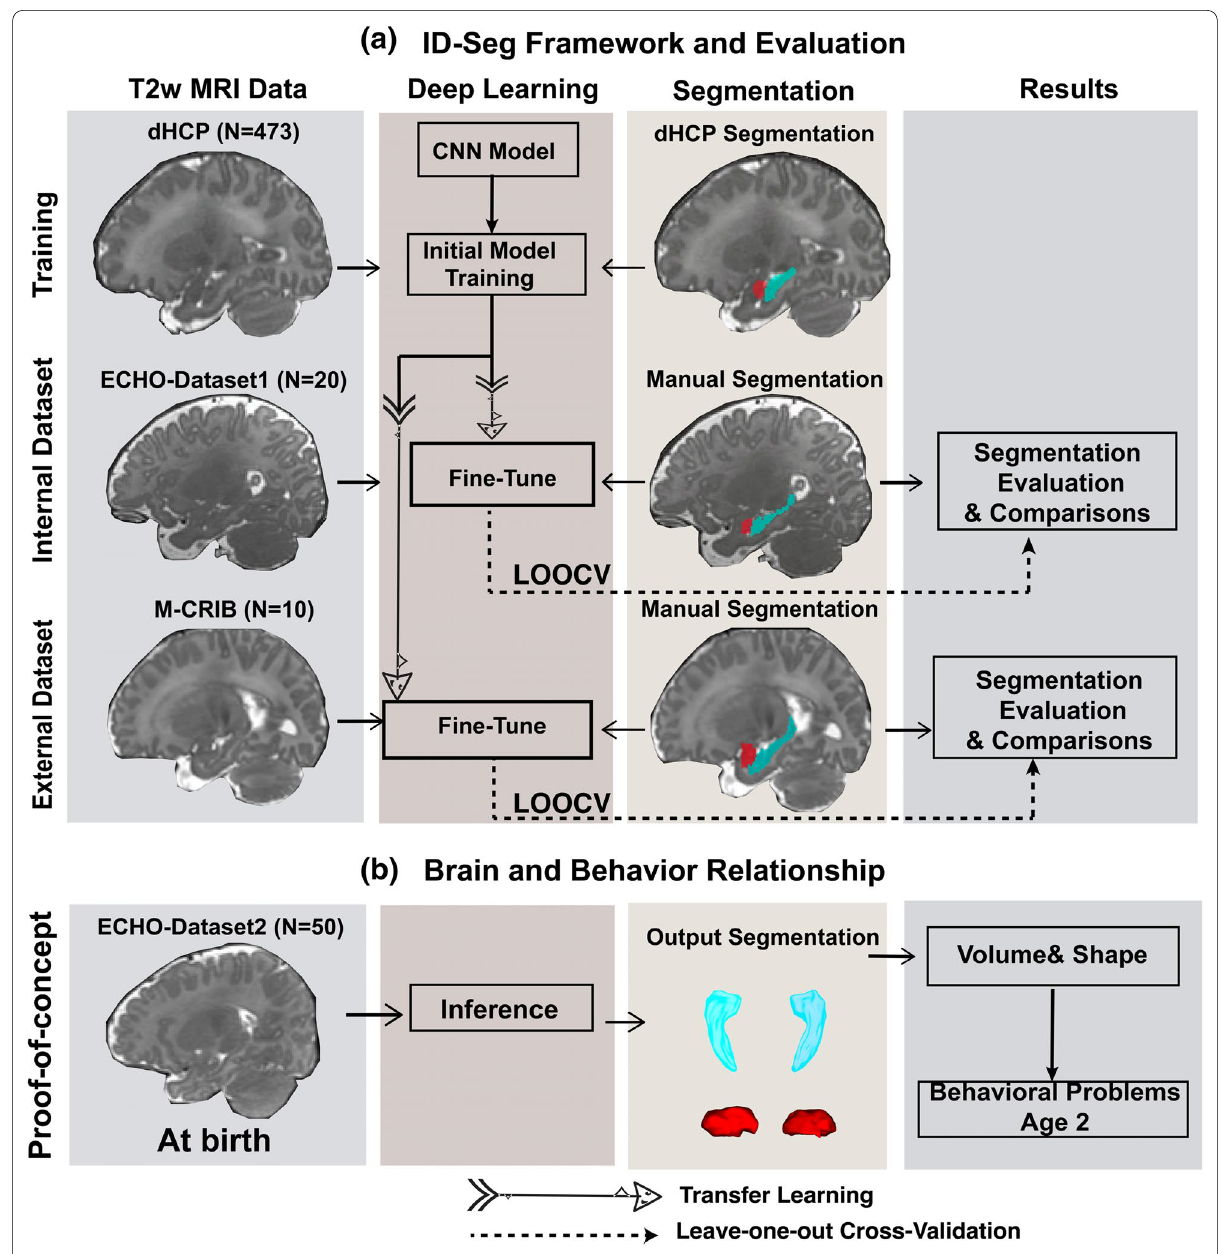
Fig. 1 Overview of this study. a Using 3 independent infant MRI datasets through a transfer-learning approach, we trained, fine-tuned, and cross-validated a deep-learning segmentation framework (ID-Seg) for hippocampus and amygdala, both with internal and external datasets; b we further explored the prospective associations between morphometric measures (left and right hippocampus and amygdala) in infants and behavior problems at age 2. *Cyan color represents segmented hippocampus, and red represents segmented amygdala. LOOCV leave-one-out